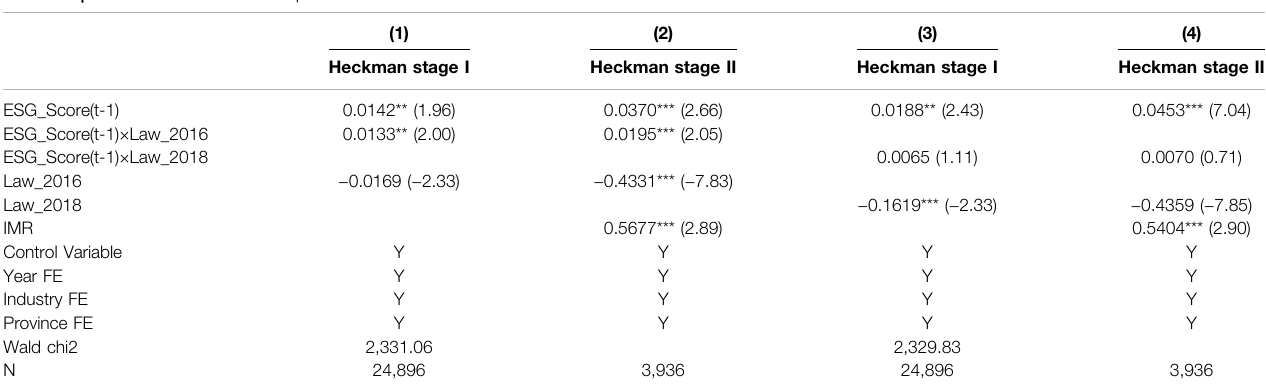
TABLE 9 | Effect of the environmental protection tax